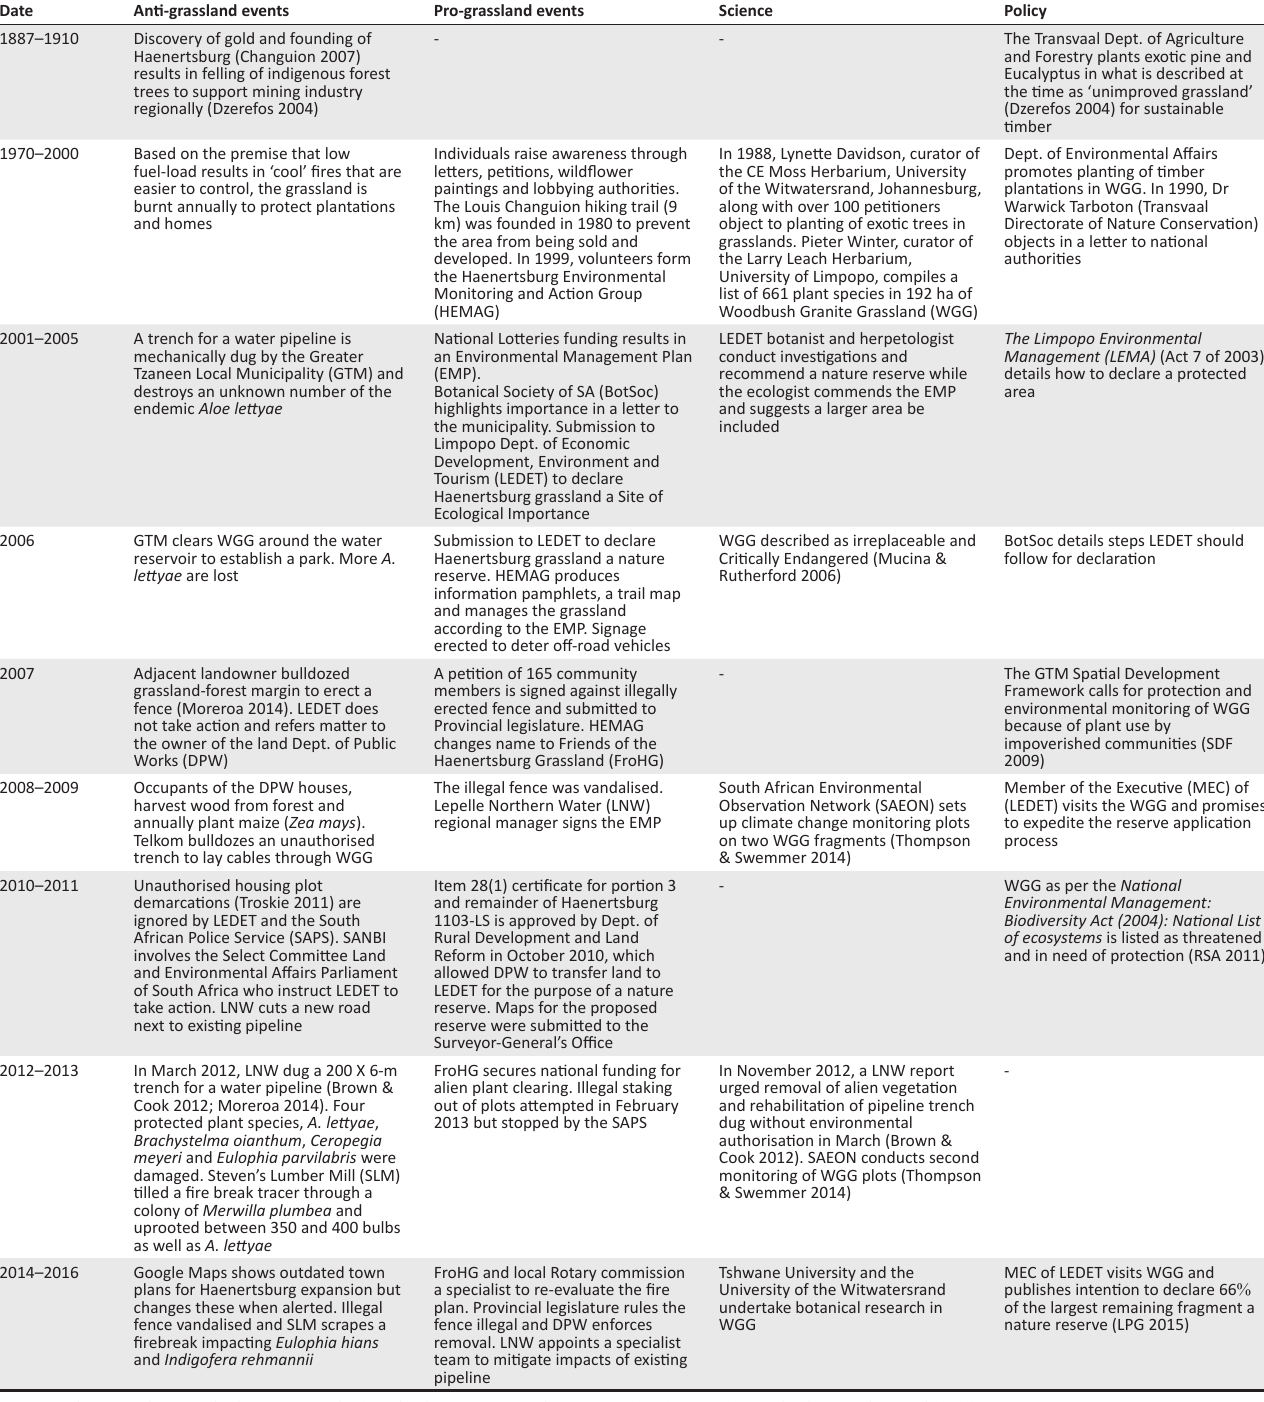
TABLE 1: Chronology of events pertaining to the largest remaining continuous section of Woodbush Granite Grassland, adjacent to Haenertsburg village, Limpopo